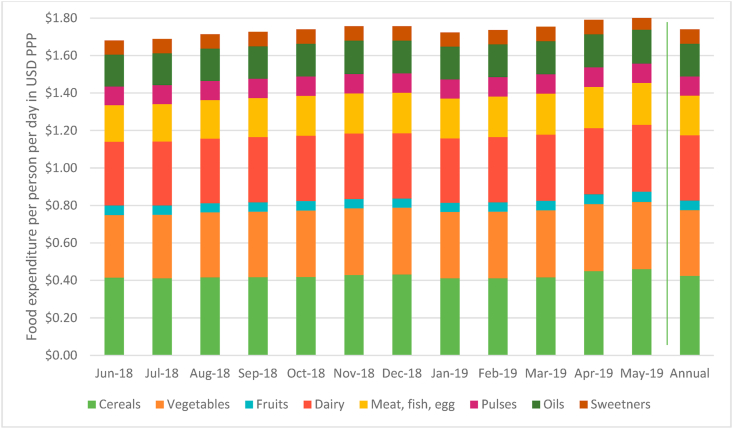
Seasonal variation in All- India rural food expenditures, June 2018–May 2019.